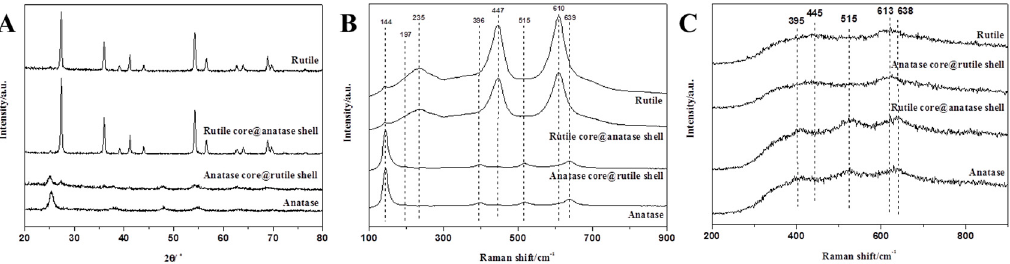
Figure 8. ( A ) XRD pattern, ( B ) visible Raman spectra, and ( C ) UV Raman spectra of anatase core@rutile